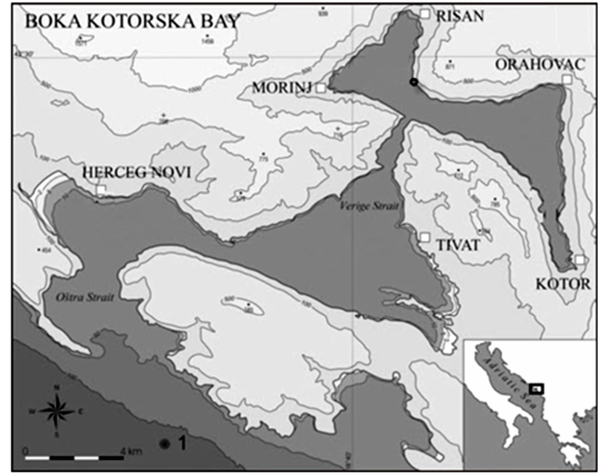
Figure 8. Sampling station of Rt Murva ( • ) in the Bay of Kotor (Montenegro; inset: study area, southern Adriatic Sea, adopted from Ivoševi´c DeNardis et al.,